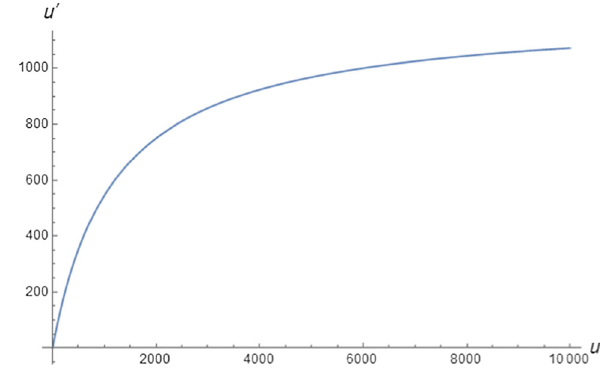
Fig. 7 The Polymer BKL map for u (116a) is plotted for Q = 1 / 10. There a plateau u (cid:11) ≈ 1200 is reached at about u ≈ 10 4 . This means that for any u (cid:3) 10 4 the next u (cid:11) will inevitably be u (cid:11) ≈ 1200, no matter how big u